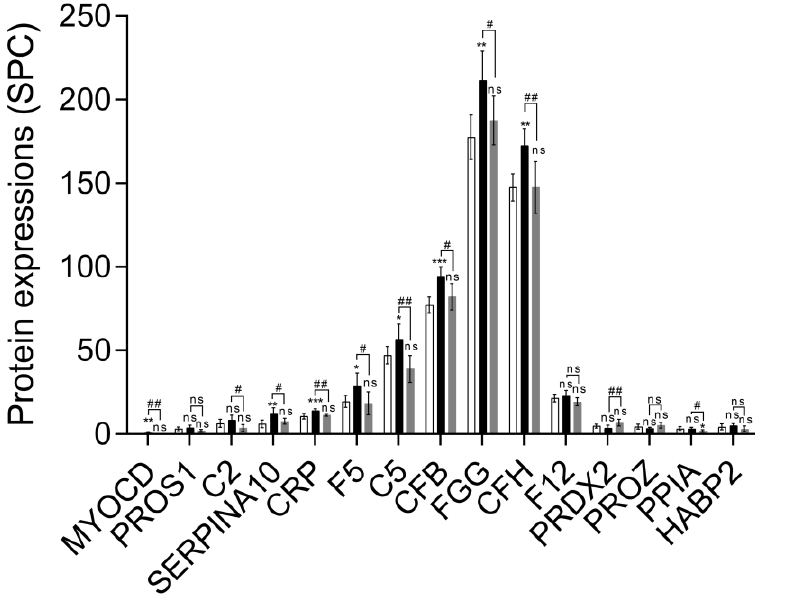
Figure 3. Effects of exercise on cardiovascular and hematological-disease-regulated proteins in ApoE knockout mice. The results are expressed as means ± standard deviation ( n = 6). One-way ANOVA followed by Tukey’s post hoc test was used for statistical analysis, and * p < 0.05, ** p < 0.01, and *** p < 0.001 represents the significance between ND and WD groups or ND and WD EX groups. # p < 0.05 and ## p < 0.01 represents the significance between WD and WD EX groups. ns = No significant difference.